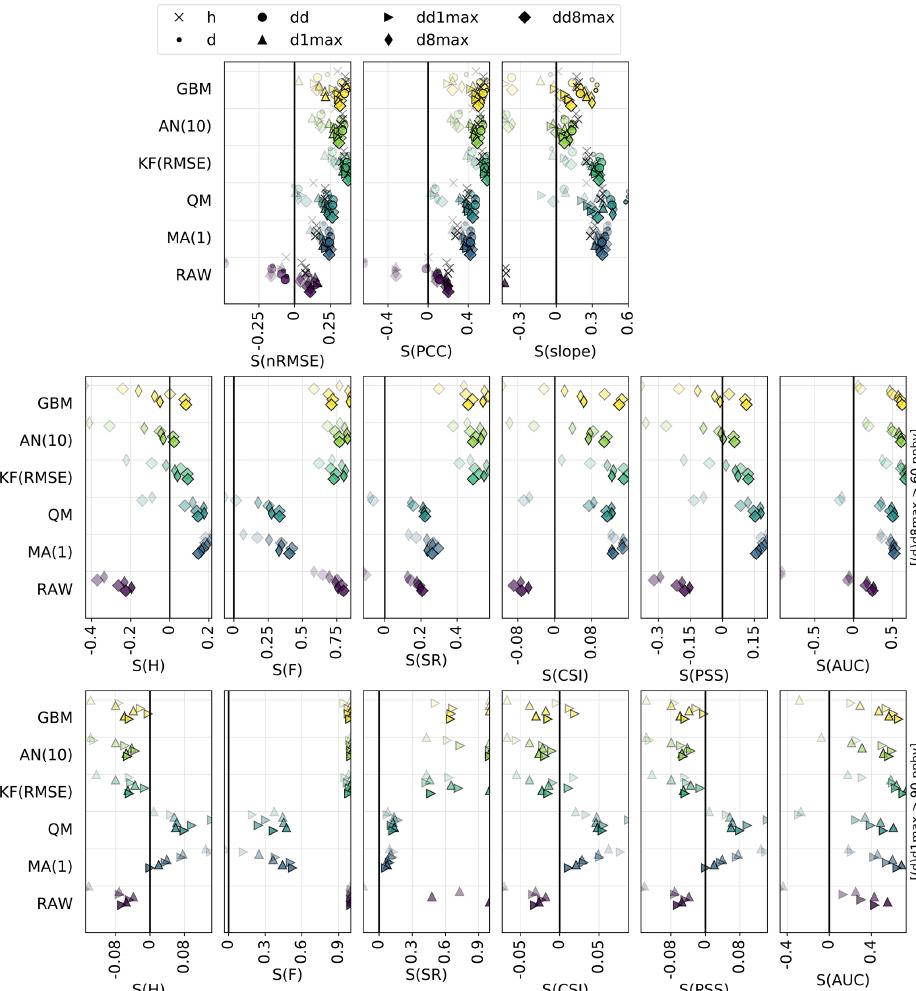
Figure 4. Similar to Fig. 3 for skill scores (see Sect. 2.5 for details on the calculation of these skill scores). For clarity, the highest negative values (mostly obtained on RAW and/or shortest lead times) are cut but can be seen in Fig. S1 in the